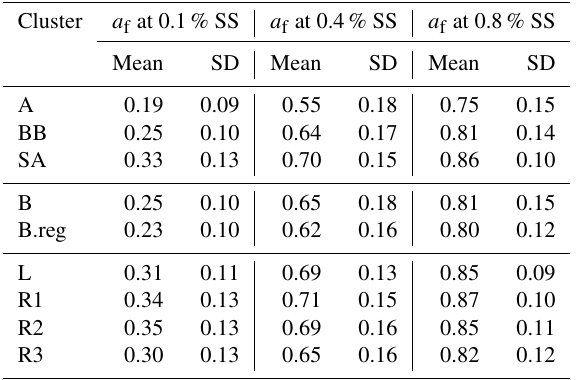
Table 4. Mean activated fractions at 0.1%, 0.4%, and 0.8% SS for all clusters.